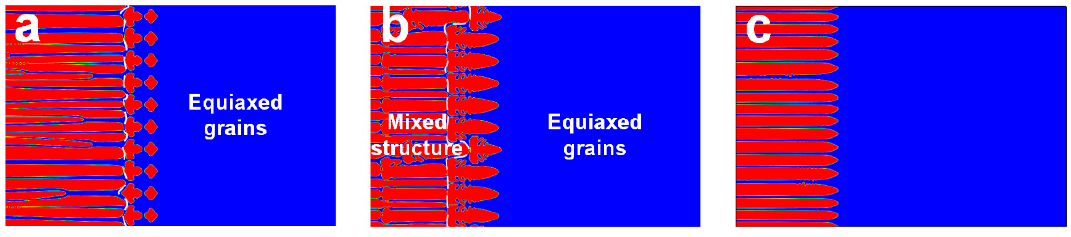
Figure 7. Effects of the nucleation undercooling on the CET for D n = 200 ∆ x and X f = 200 ∆ x : ( a ) U n = 11 K; ( b ) U n = 16 K; ( c ) U n = 21 K.